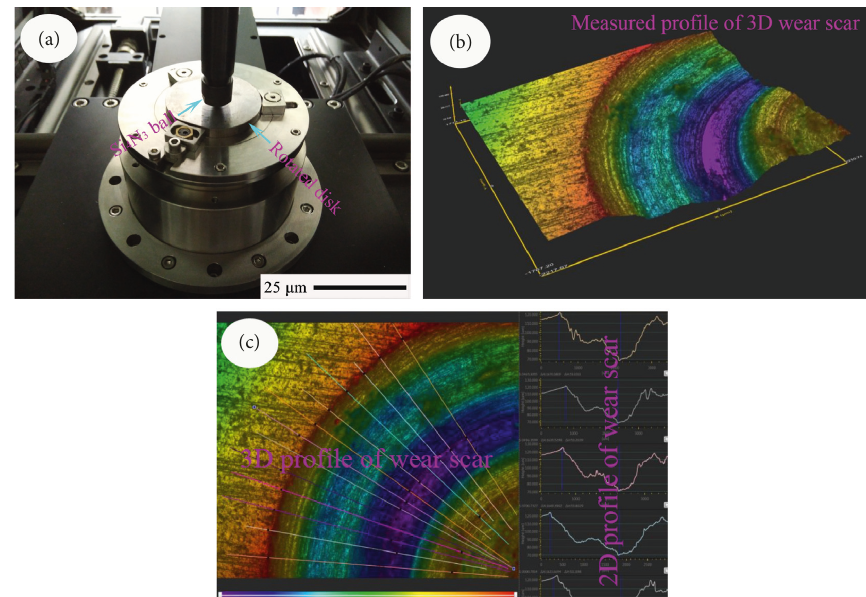
Figure 3: Typical schematic diagram (a) of the TASC/Si 3 N 4 tribo-pair; 3D (b) and (c) 2D profiles of the wear scars of a